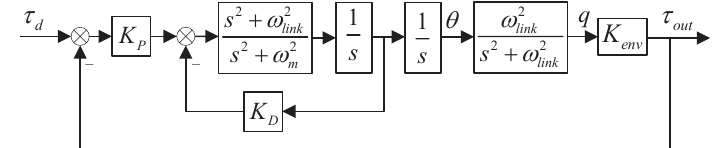
Figure 9. Resonance proportional torque control structure